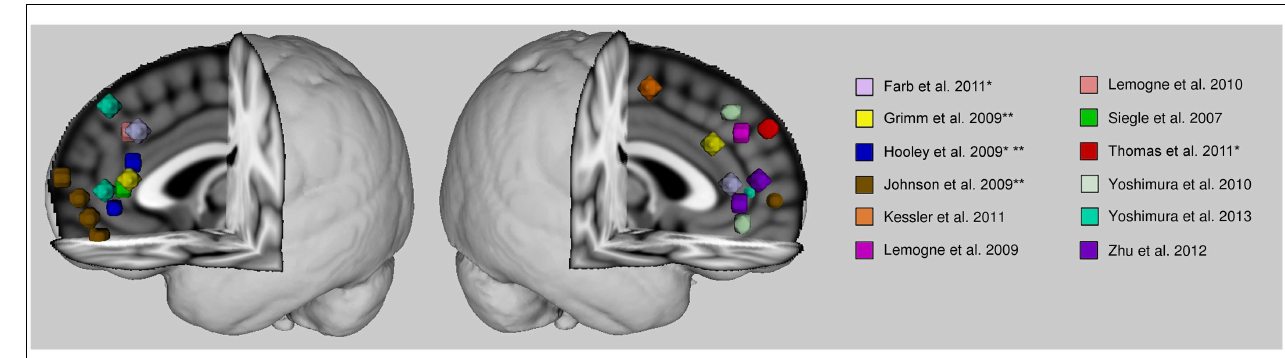
FIGURE 1 |Anterior cortical midline findings of previous studies reporting self-related abnormalities in depression . Spheres are centered on peak voxel values of regions whose activities are reported significantly different in major depressive patients from healthy control subjects during self-referential processing, or during another paradigm (e.g., rest or emotional